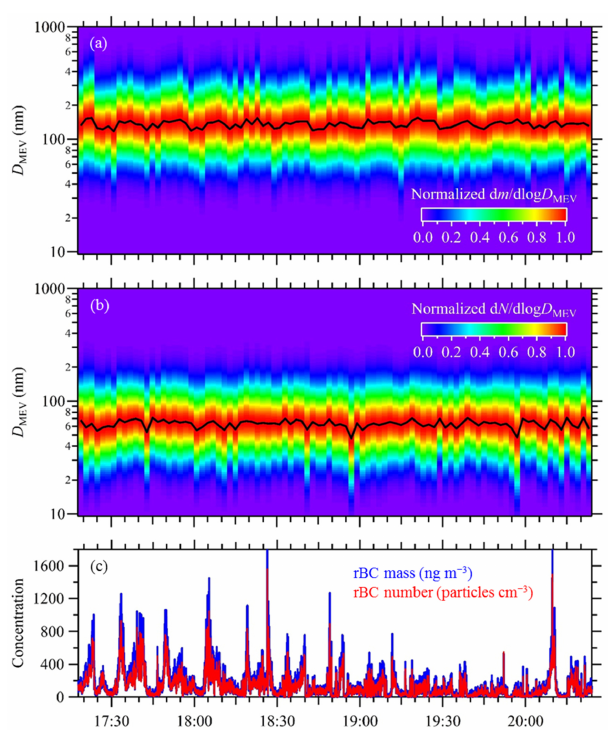
Figure 5. Time-resolved rBC (a) mass size distribution, (b) num- ber size distribution and (c) concentrations observed over the SUN facility during F_8/28. Solid lines in (a) and (c) indicate MMD and NMD, respectively. The horizontal axis shows UTC time. The flight track of F_8/28 is shown in Fig. 1a.